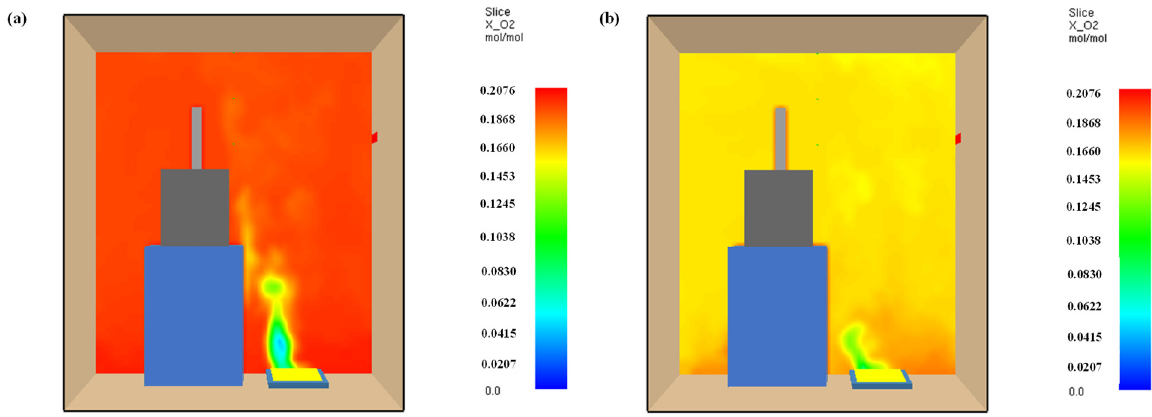
Figure 12. Velocity distribution contours plotted on the XZ-center plane.